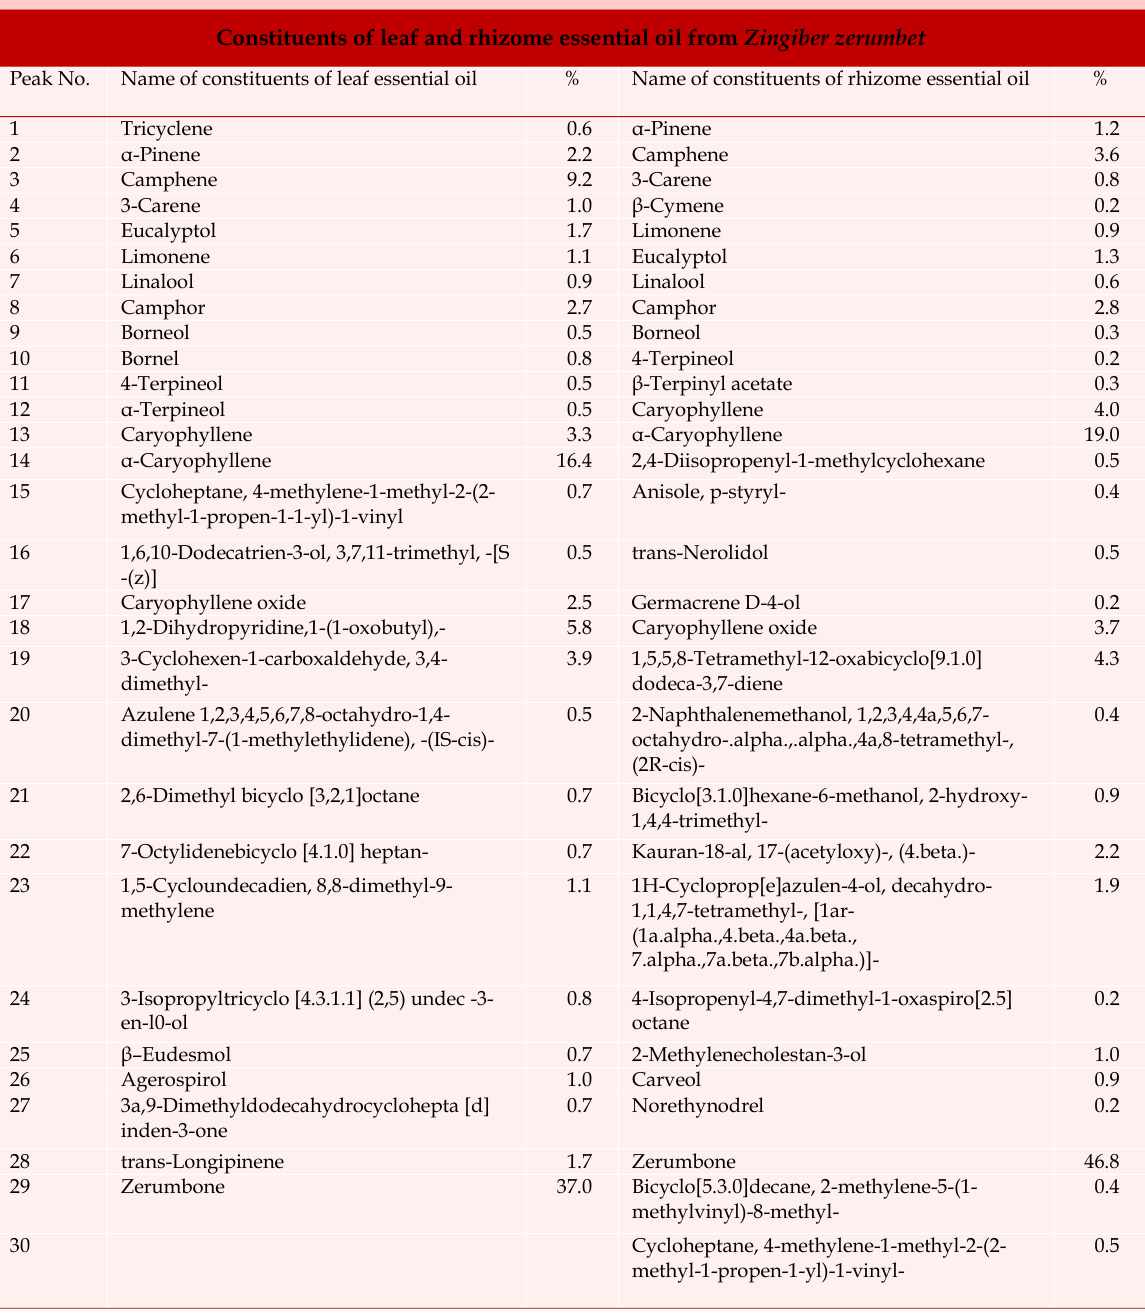
Constituents of leaf and rhizome essential oil from Zingiber